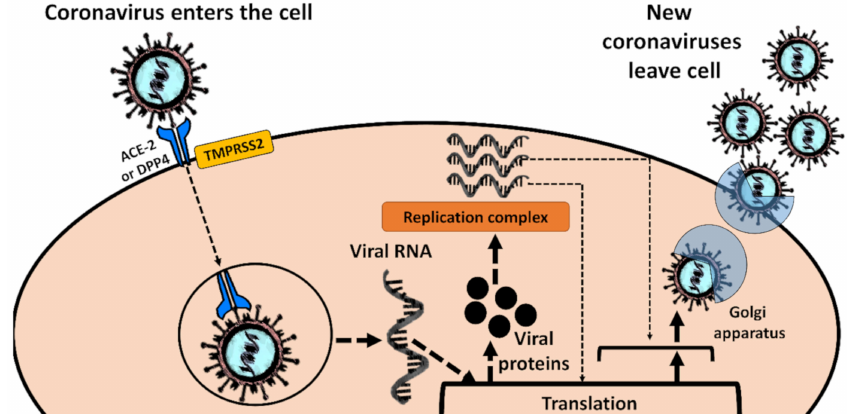
Figure 2. A general scheme of cellular entry of coronaviruses that pose the highest human health risks, namely SARS-CoV, SARS-CoV-2 (entering via ACE2) and MERS-CoV (facilitated by DPP4), and further virus